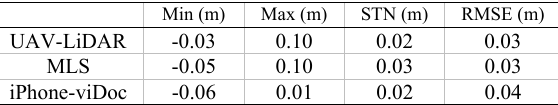
Table 1. Error statistics for point cloud data